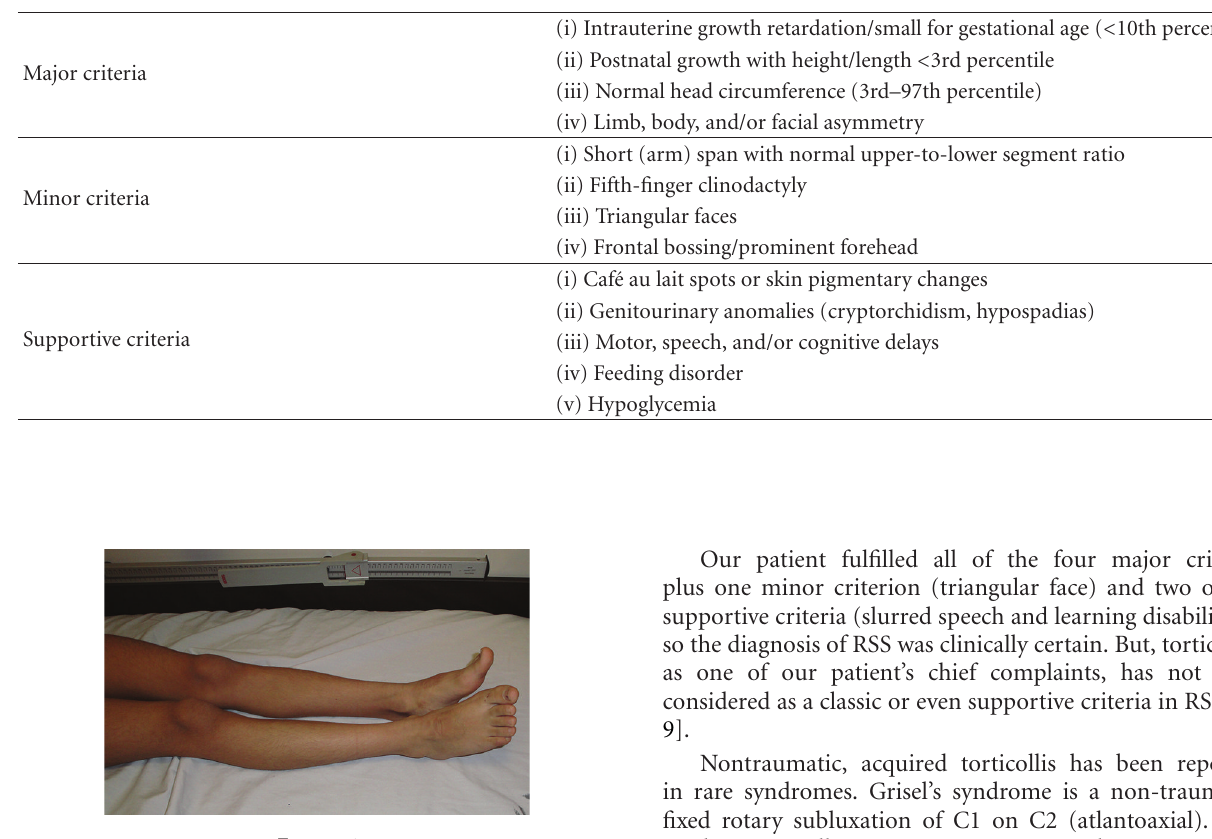
Table 1: Clinical criterion for Russell-Silver